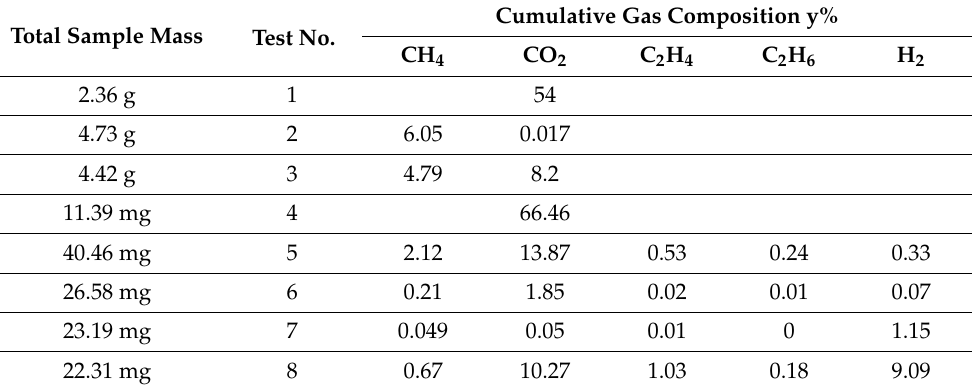
Table 5. Cumulative gas compositions determined by gas chromatography from isothermal calci- nation reactions of calcium carbonate and magnesium carbonate with various ratios of biomass/ resin (plastics). Test